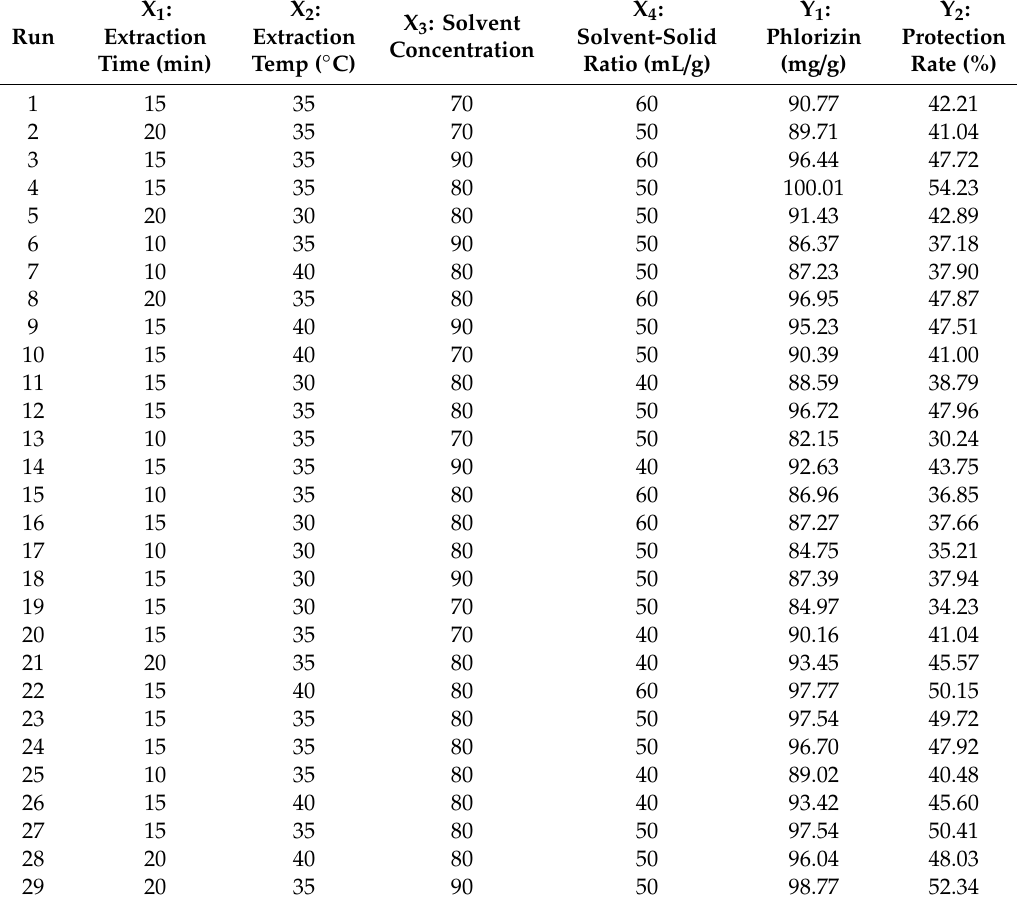
Table 2. BB design for actual factors and results for response surface